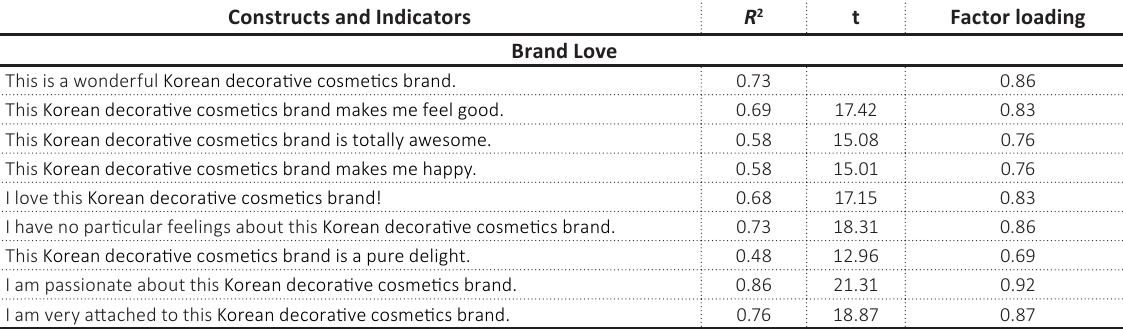
Table 4 (cont.). Items and their loadings